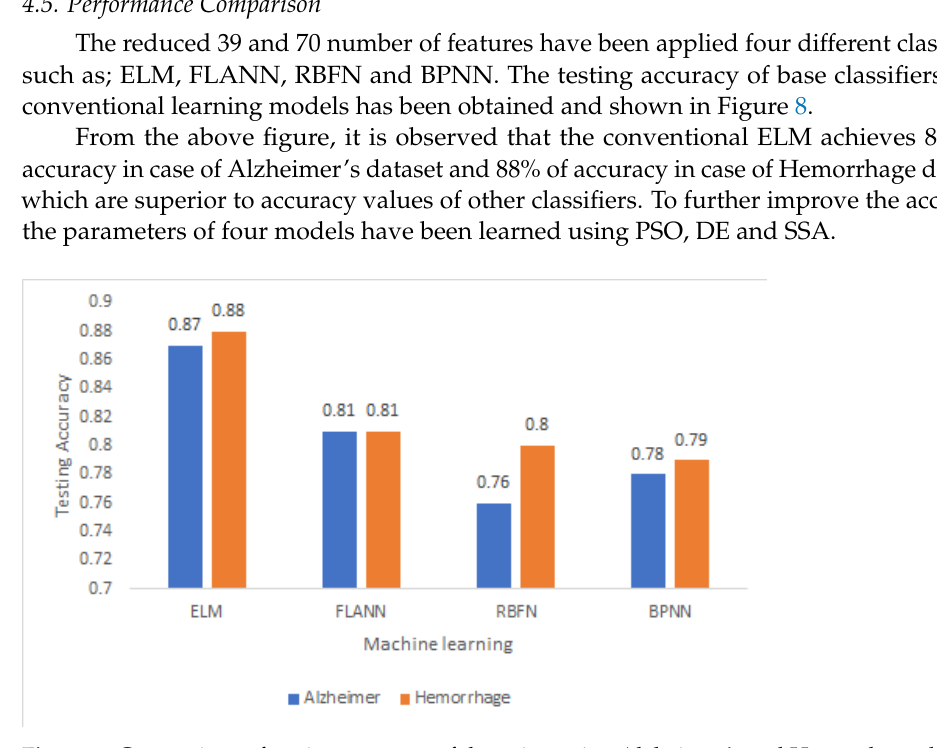
Figure 8. Comparison of testing accuracy of detection using Alzheimer’s and Hemorrhage datasets to ELM, FLANN, RBFN, and